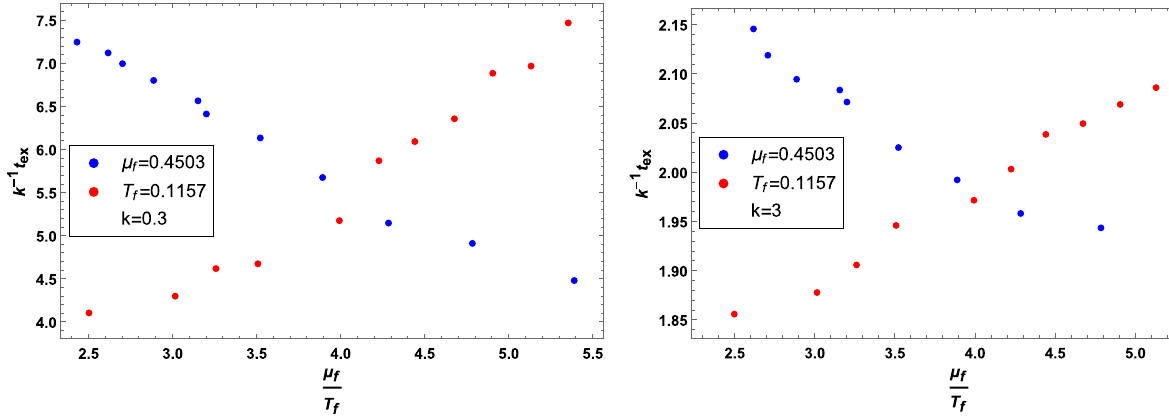
Fig. 5 The excitation time in terms of μ f / T f for l = 1 In Fig. 5 (left), blue points, the final temperature of the